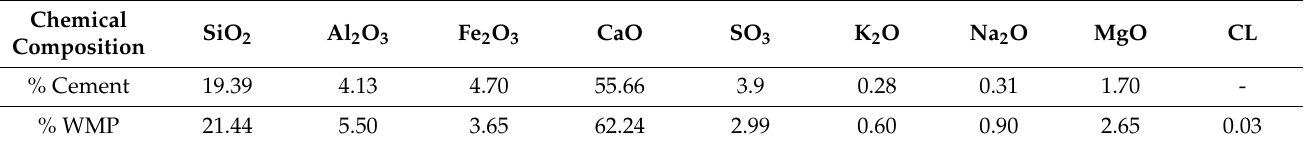
Table 1. Chemical compositions of cement and WMP.